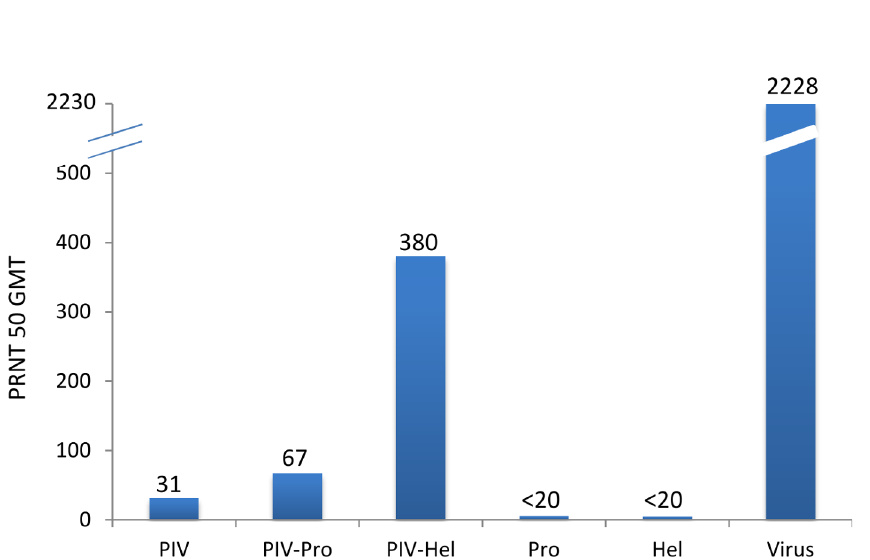
Fig 4. Neutralizing antibody responses. Anti-DENV-2 neutralizing antibody responses in immunized mice on Day 35 after first inoculation. Neutralizing antibody titers were determined for each animal by plaque reduction neutralization test (PRNT). The Y-axis indicates reciprocal 50% PRNT (PRNT 50 ) titers (Log 10 ). For calculation purposes, titers < 20 were given a value of 5. PIV = purified inactivated vaccine, Pro = protease, Hel = helicase.